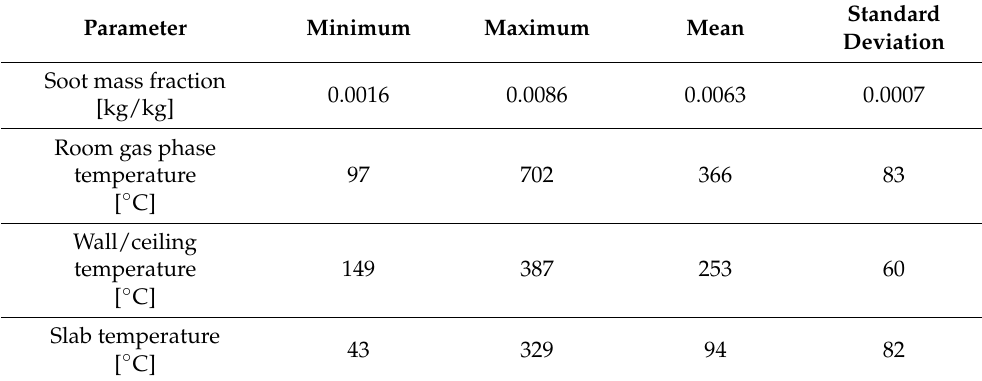
Table 4. Descriptive statistics for the established timelines, recorded by devices for the entire initial region or boundary condition.